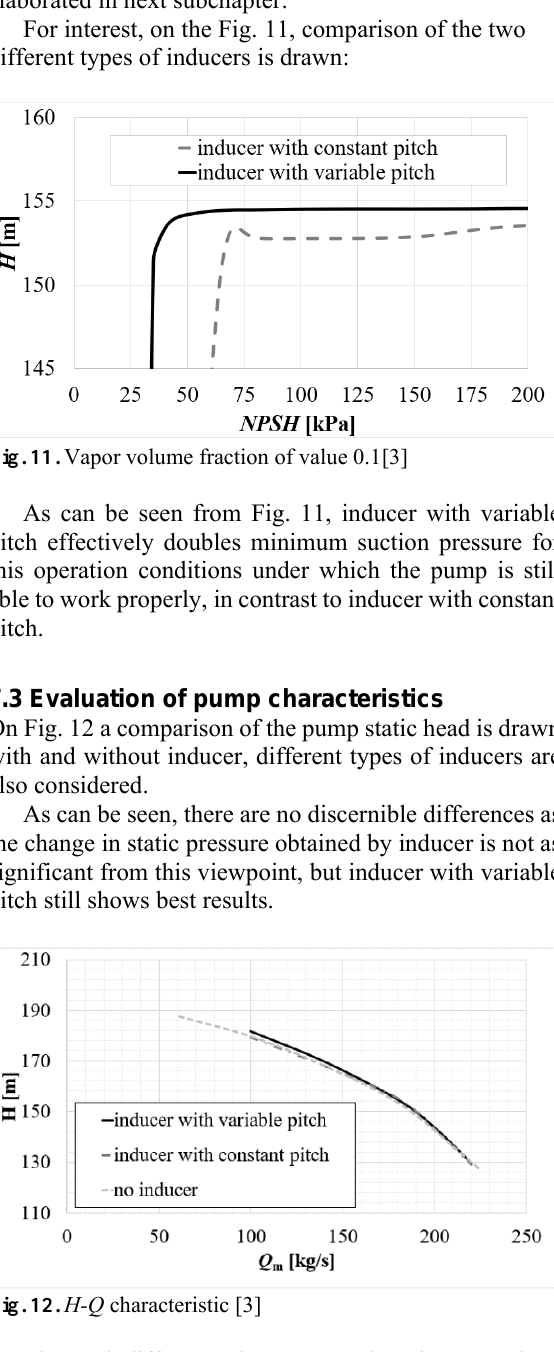
Fig. 13. NPSH 3 characteristic [3]